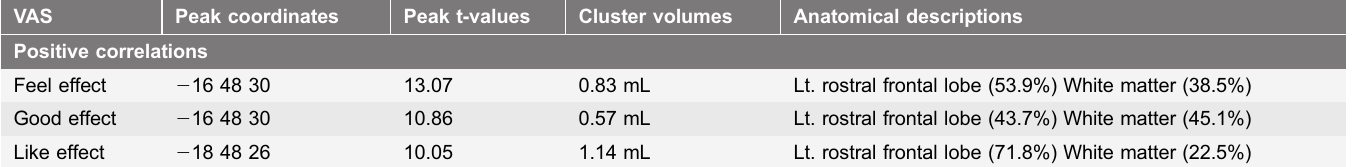
Table 3. Clusters of D [ 11 C]carfentanil BP ND (placebo - active) to D VAS (active - placebo) correlation.